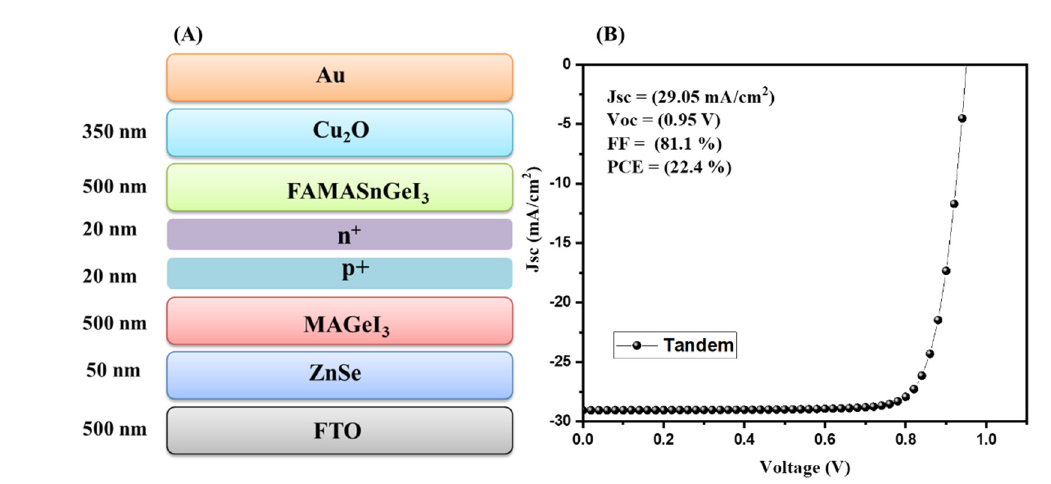
Figure 3. Schematic device structure ( A ) and J–V curve ( B ) of tandem with ZnSe as the ETL.